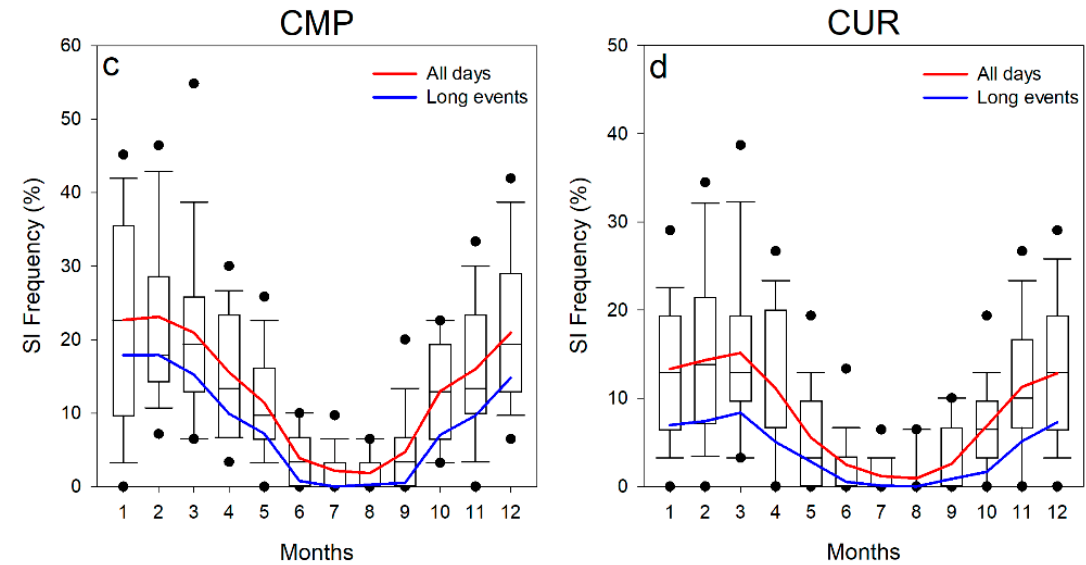
Figure 6. Box-and-whisker plot of the annual variation in SI frequency at the four measurement sites (( a )—CMN, ( b )—PRS, ( c )—CMP, and ( d )—CUR), computed by considering all of the SI events. The solid lines indicate the average climatological (1979–2017) annual variation, computed by considering all SI days (red) and events longer than three days (blue).